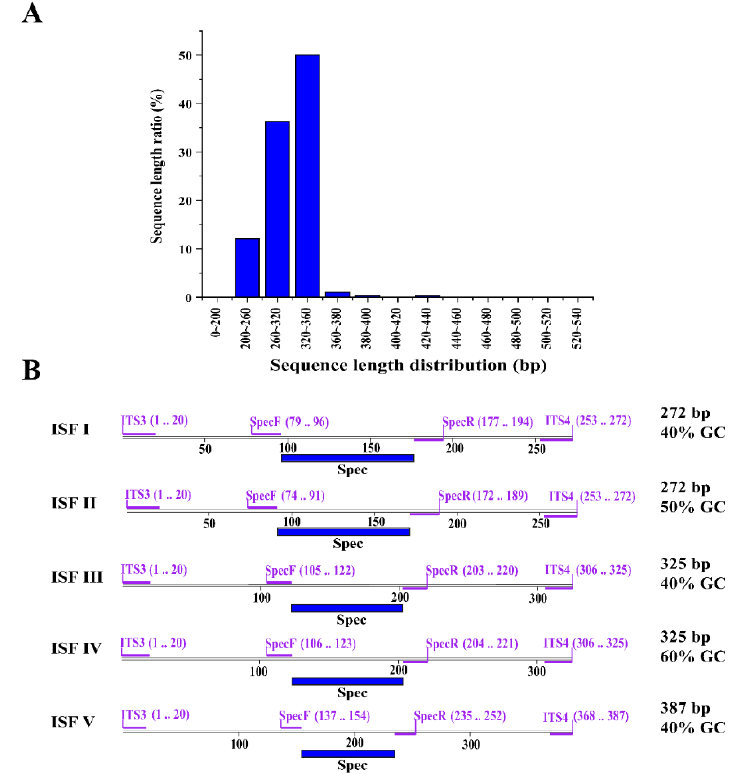
Figure 1. Length distribution and five ISFs. ( A ) Fungal ITS2 sequence length distribution. ( B ) The sequence lengths and GC contents of ISF I, II, III, IV, and V were 272 bp, 40% GC; 272 bp, 50% GC; 325 bp, 40% GC; 325 bp, 60% GC, and 387 bp, 40% GC, respectively. Spec indicates a specific fragment of 116 bp. Table 1. Screened fungi and five ISFs a.